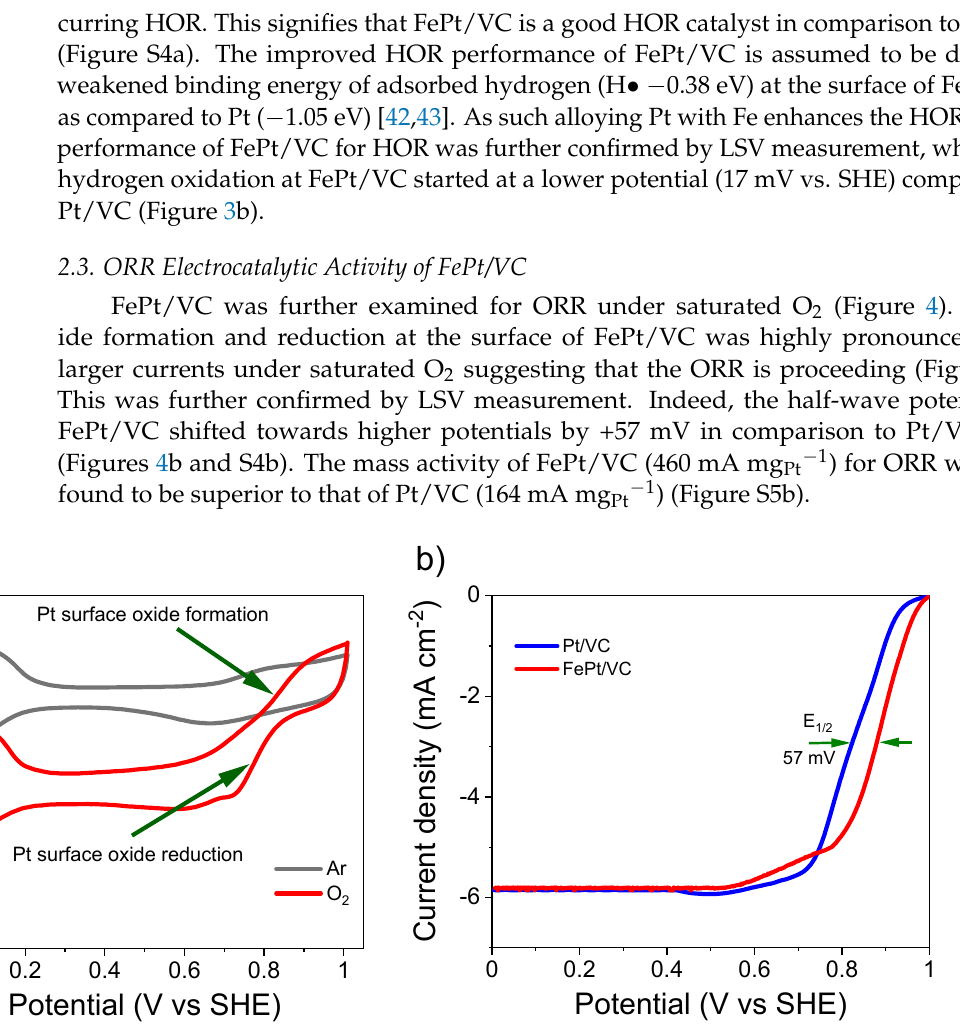
Figure 4. ORR activity of FePt/VC, including ( a ) its CV at scan rate 50 mV s − 1 @ 1600 rpm in 0.1 M aqueous HClO 4 under saturated Ar and O 2 , and ( b ) the LSV comparison between FePt/VC and Pt/VC at the scan rate of 10 mV s − 1 @ 1600 rpm under saturated O 2 . Catalyst loading was 50 µg cm − 2 .